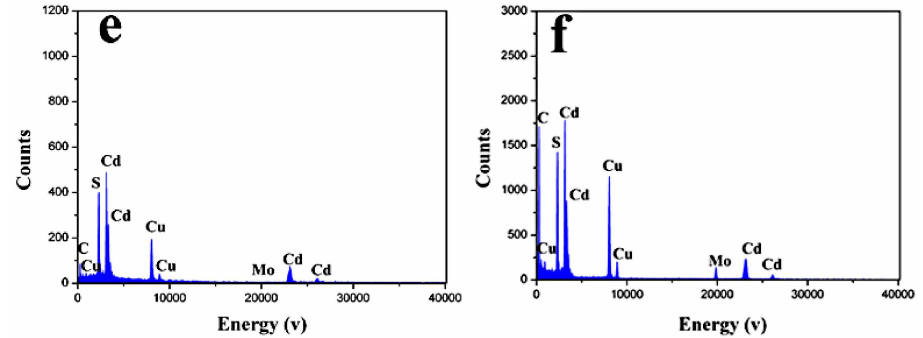
Figure 2. TEM images of pure CdS ( a ) and MoS 2 QDs/CdS ( b , c ), HRTEM image of CdS MoS 2 QDs/CdS ( d ) and EDS images ( e,f ) in the e and f areas of Figure 2c. Energy dispersive X-ray spectrometry (EDS) mapping analysis of the MoS 2 QDs/CdS